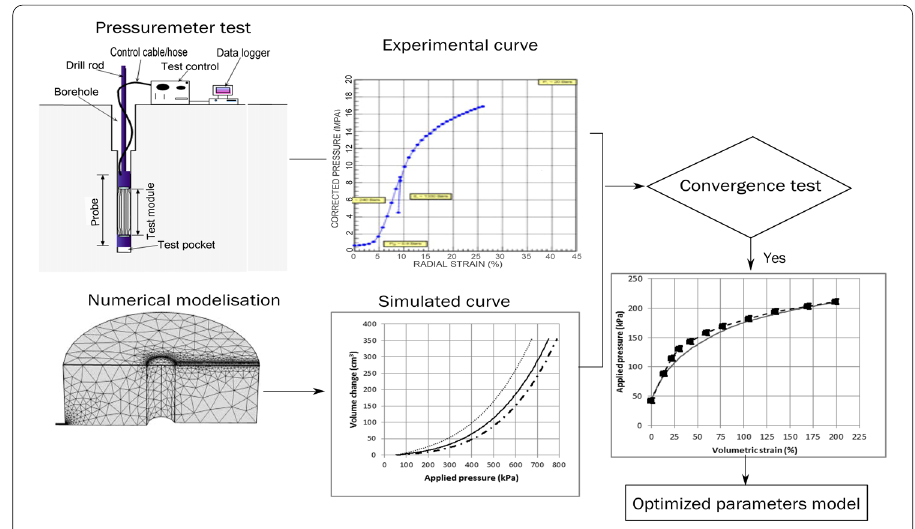
Fig. 6 The optimization